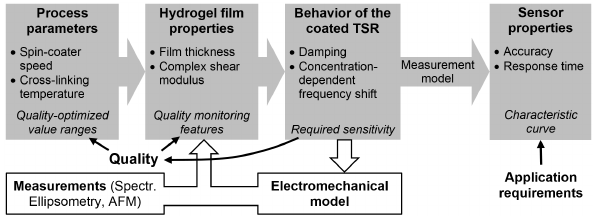
Figure 2. Methodology of the manufacturing process with a com- prehensive optimization